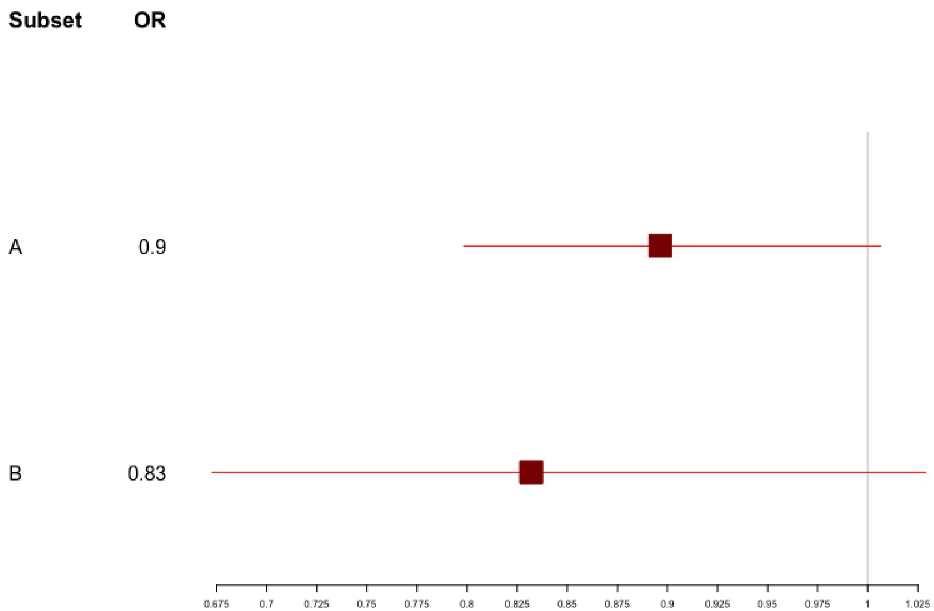
Fig 2. Forest plot HR of rate of death and/or MV between DXM and R+DMX groups in the matched population according to duration of symptoms before treatment initiation: A) � 5 days, B) � 5 days.